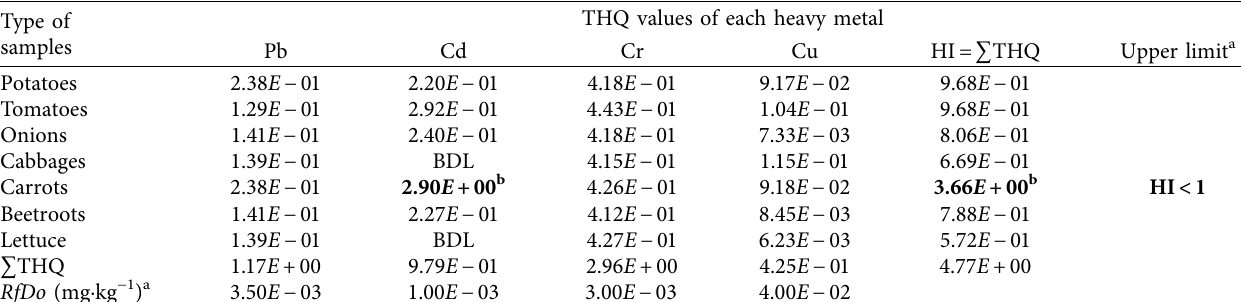
Table 8: THQ values of individual heavy metals through the consumption of diferent vegetables in the study area. Type of